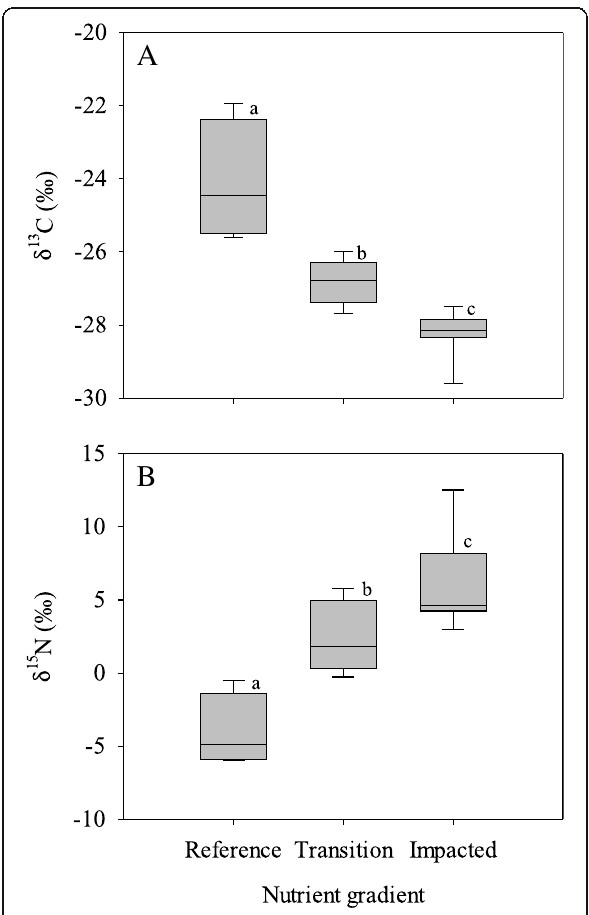
Fig. 2 Box plots of cattail δ 13 C ( a ) and δ 15 N ( b ) values at the reference, transition, and impacted sites from south Florida